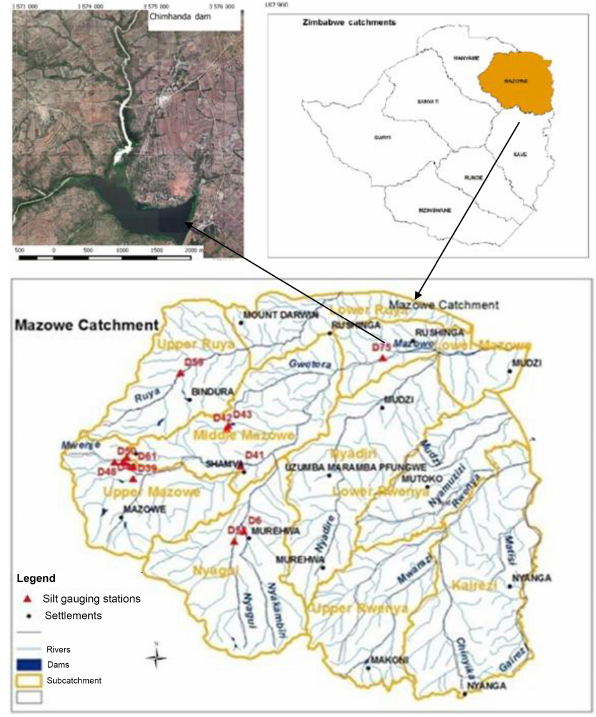
Figure 1. Mazowe Catchment and location of Chimhanda